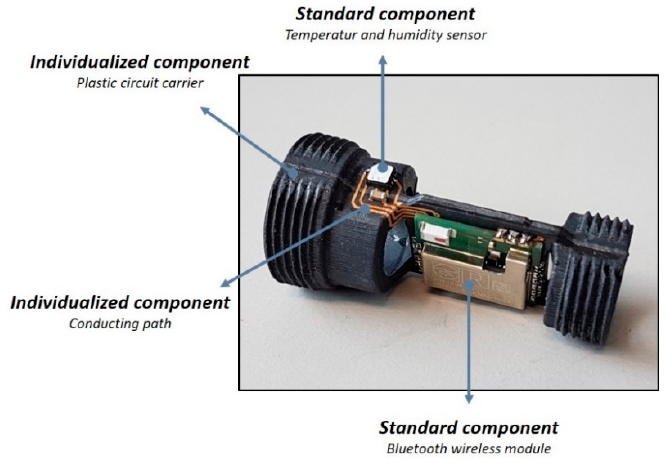
Figure 4. Smart connector as iMMS.